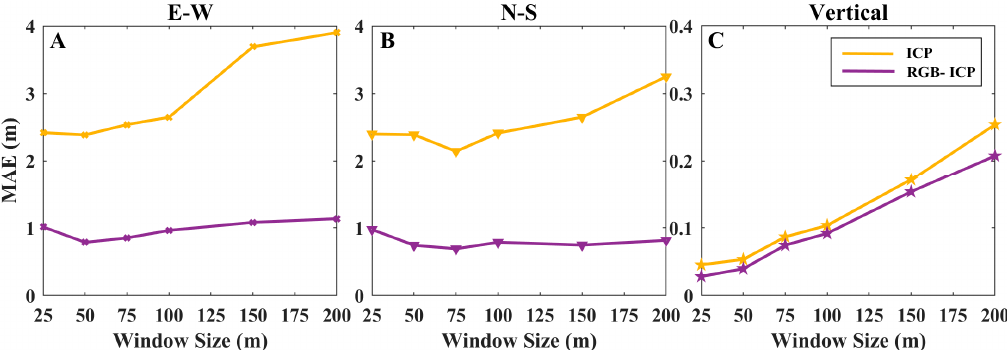
Figure 8. Error variation using different windows on ALS data (Wellington, New Zealand; smooth terrain): ( A ) MAE in the E-W direction; ( B ) MAE in the N-S direction; ( C ) MAE in the vertical direction.